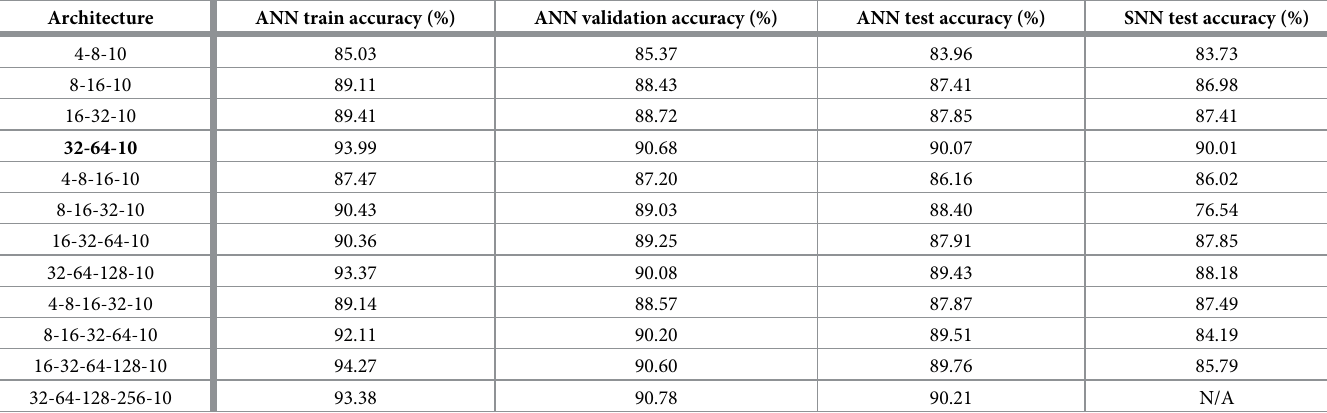
Table 1. Various CNN architectures and their performance.